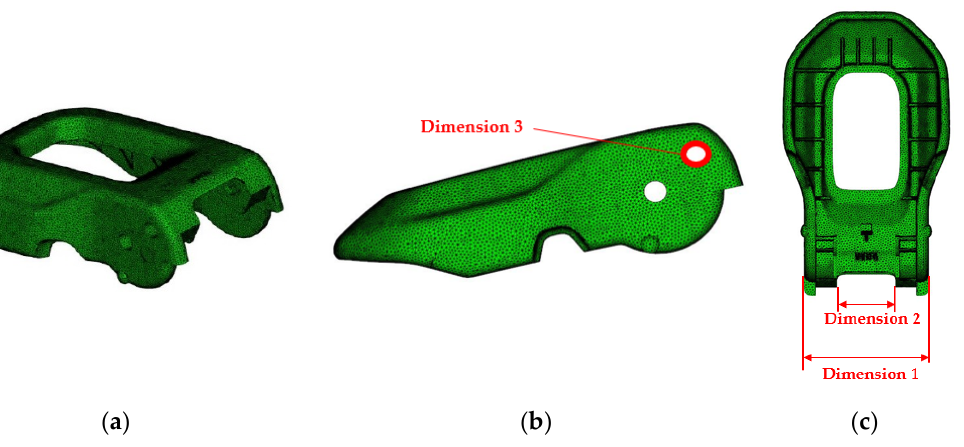
Figure 1. The shape of pivot sub-assembly. ( a ) Overview of pivot sub-assembly. ( b ) Front view of the pivot sub-assembly and location of dimensions 1 and 3. ( c ) Side view of the pivot sub-assembly and location of dimension 2.